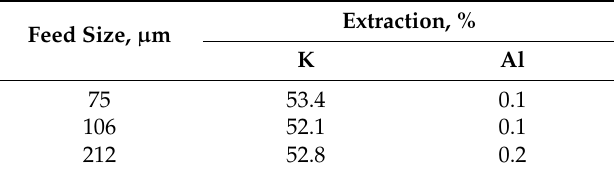
Table 4. Effect of particle size on potassium